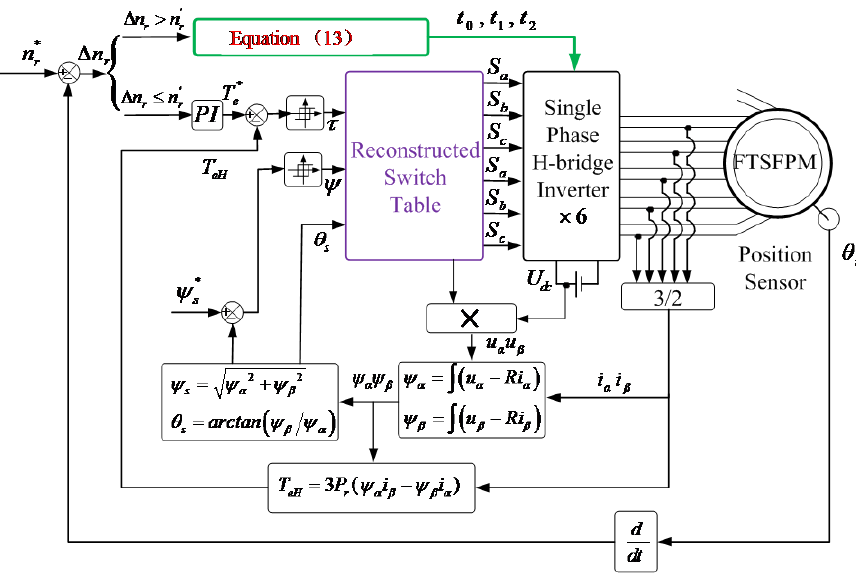
Figure 14. The RDTC system with torque integral balance control (TIBC-RDTC).